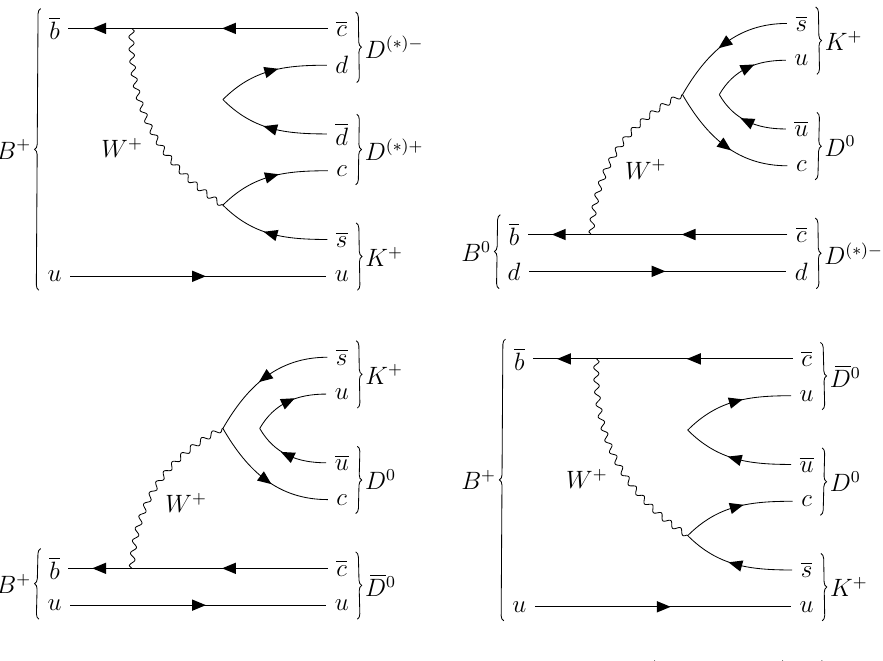
Figure 1 . Top left: internal W -emission diagram for the decays B + → D ∗− D + K + and B + → D ∗ + D − K + . Top right: external W -emission diagram for the decays B 0 → D ∗− D 0 K + and B 0 → D − D 0 K + . Bottom row: (left) external and (right) internal W -emission diagrams contributing to the B + → D 0 D 0 K +